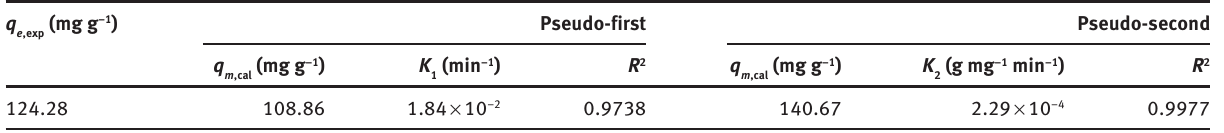
Table 1: Pseudo-first-order and pseudo-second-order kinetic constants for MB adsorption. (mg g −1 ) Pseudo-first Pseudo-second q e ,exp